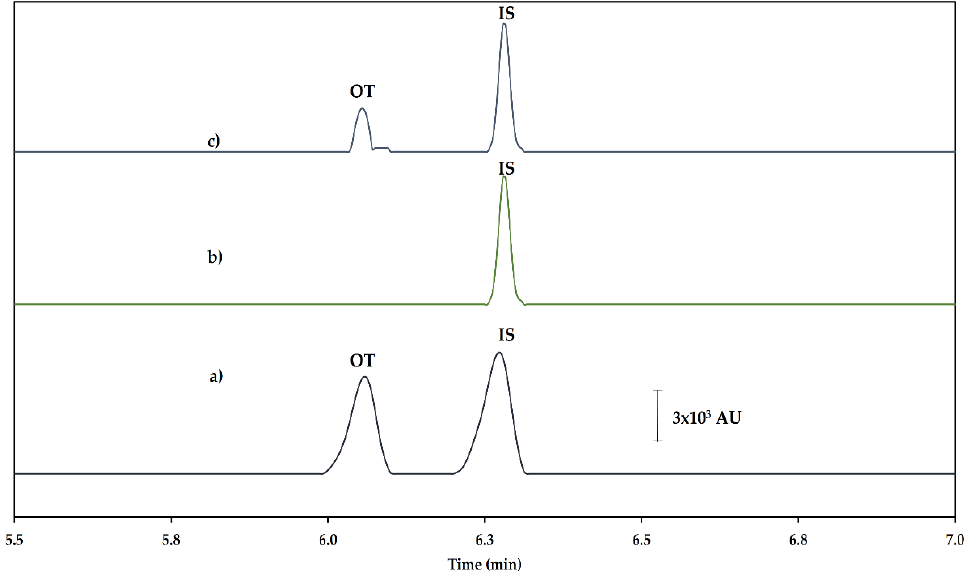
Figure 4. Electropherograms obtained for ( a ) the standard spiked sample in LVSS-CE (500 µ g L − 1 oxytetracycline (OT) and 500 µ g L − 1 IS), ( b ) the blank milk sample in SPE-LVSS-CE, and ( c ) the milk sample in SPE-LVSS-CE.